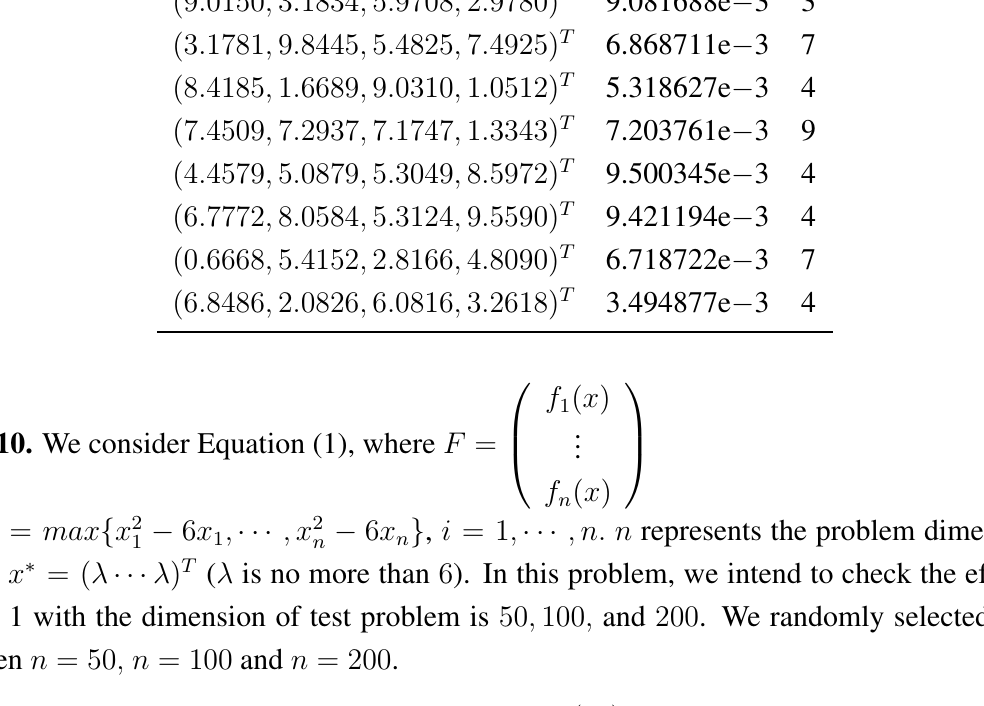
Table 10. Number of iterations, the final value of Ψ( x ∗ ) and dimension of the test